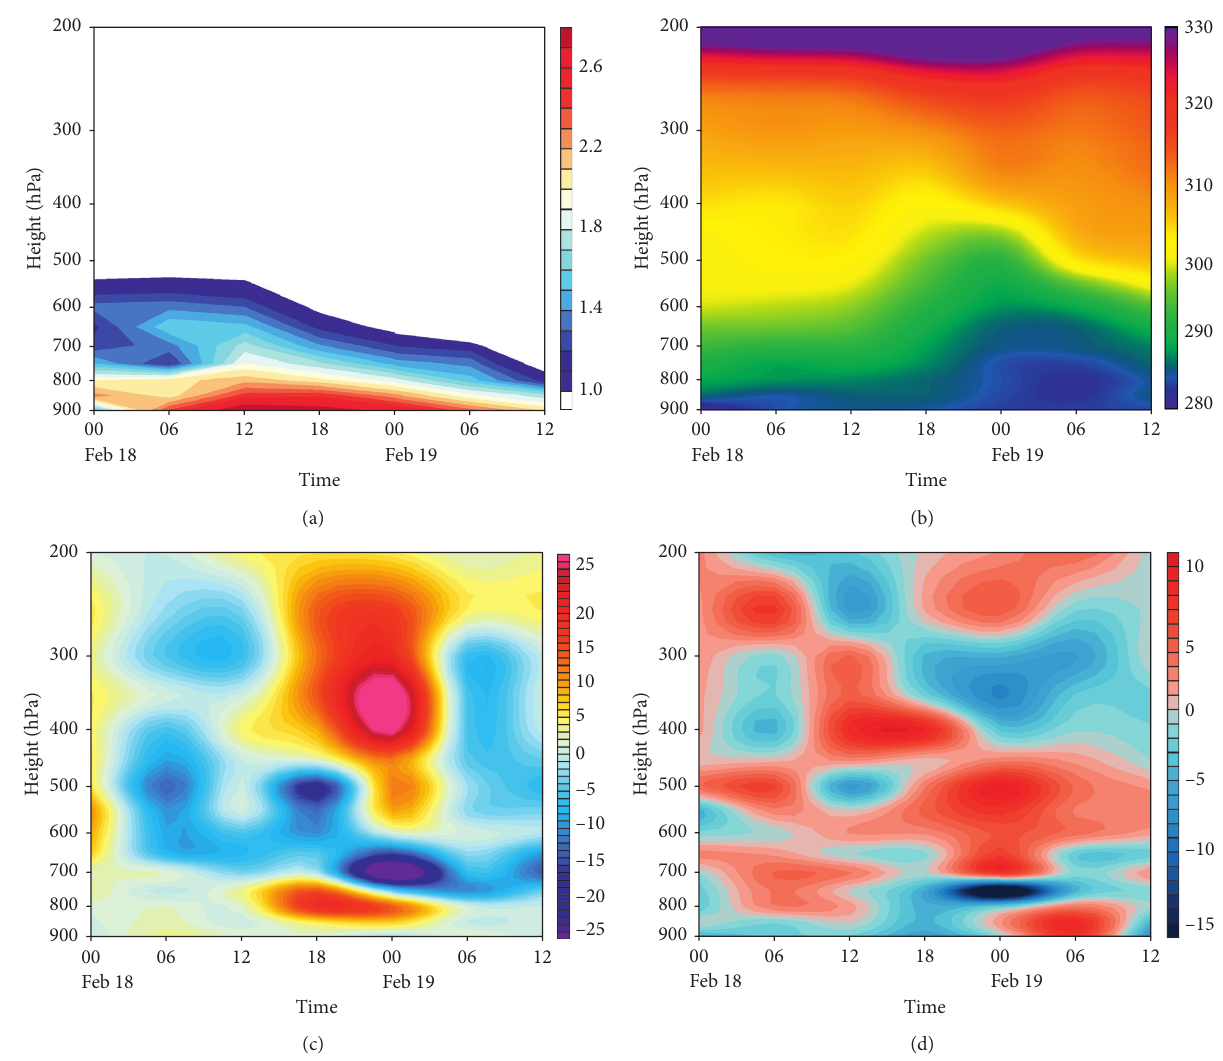
Figure 4: The time-height profile: (a) specific humidity (shadow; unit, g kg − 1 ), (b) pseudoequivalent temperature (shadow; unit, K), (c) vorticity (shadow; unit, 10 − 5 s − 1 ), and (d) divergence (shadow; unit, 10 − 5 s − 1